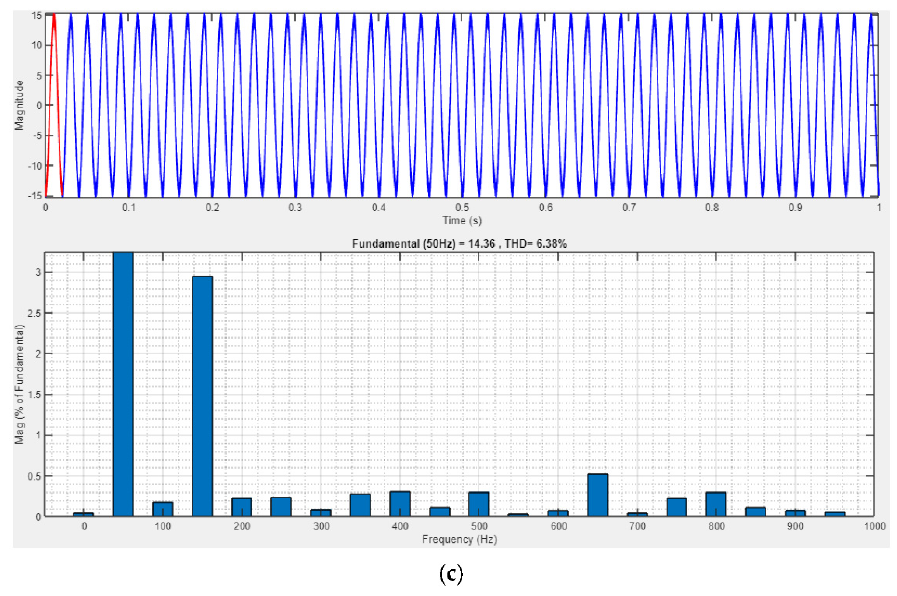
Figure 12. ( a ) R-phase load current THD, ( b ) Y-phase load current THD, and ( c ) B-phase load current THD.